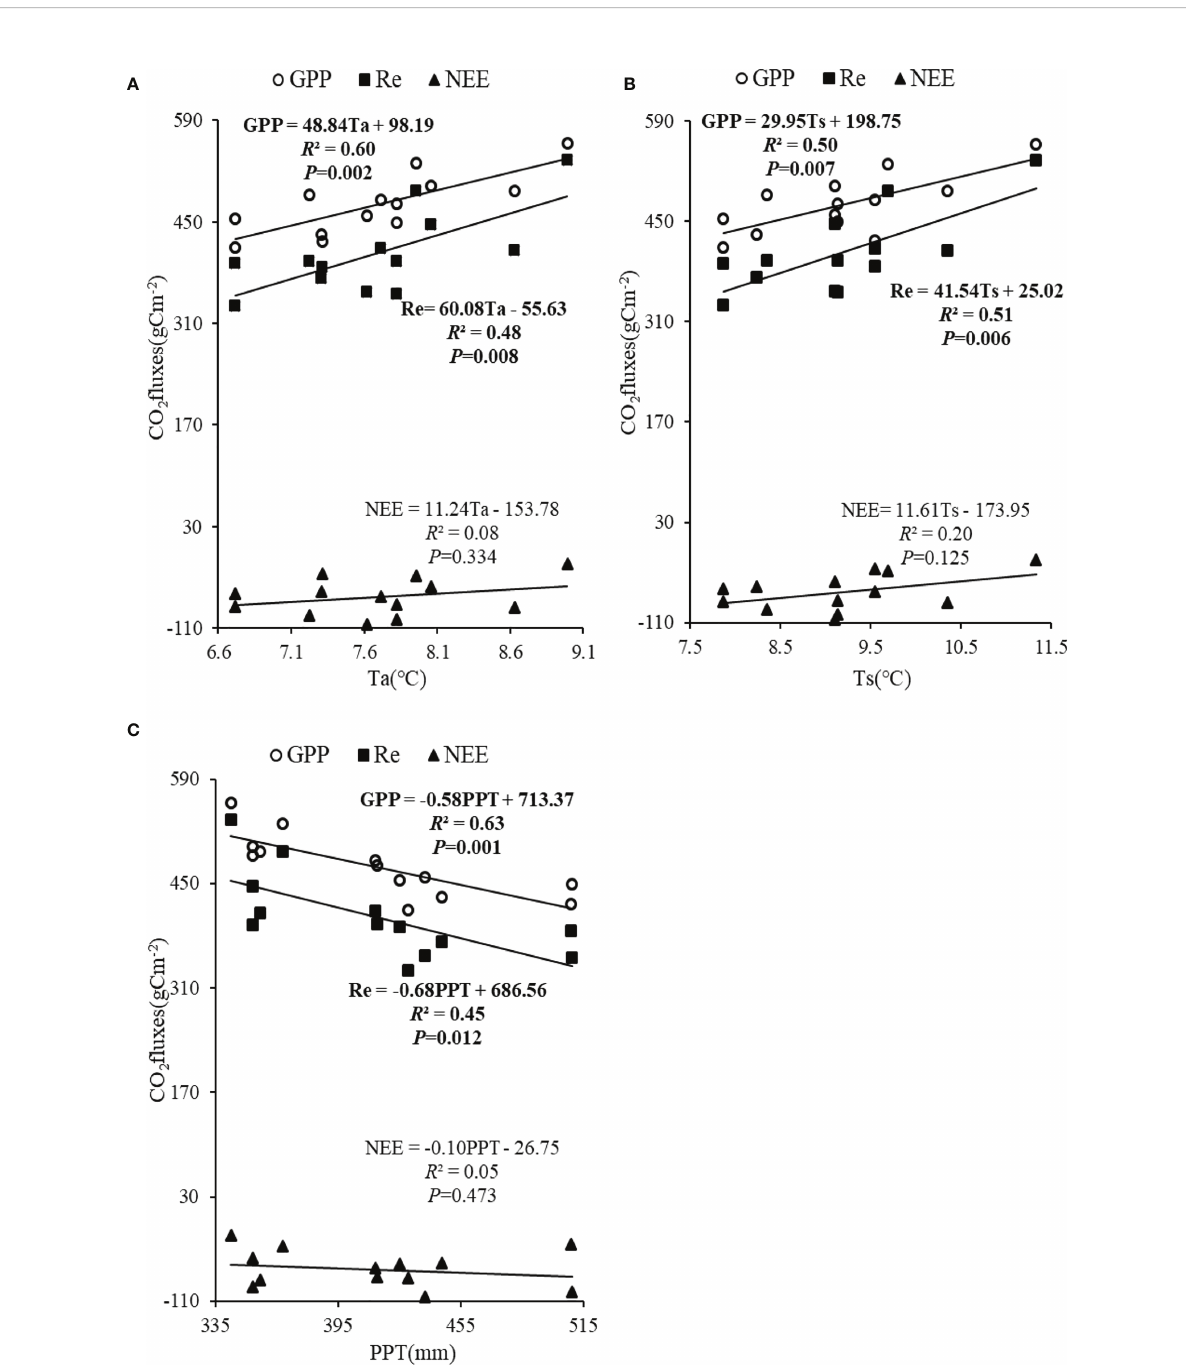
FIGURE 6 Linear regressions between seasonal CO 2 fl uxes and Ta (A) , linear regressions between seasonal CO 2 fl uxes and Ts (B) , and linear regressions between seasonal CO 2 fl uxes and PPT (C)